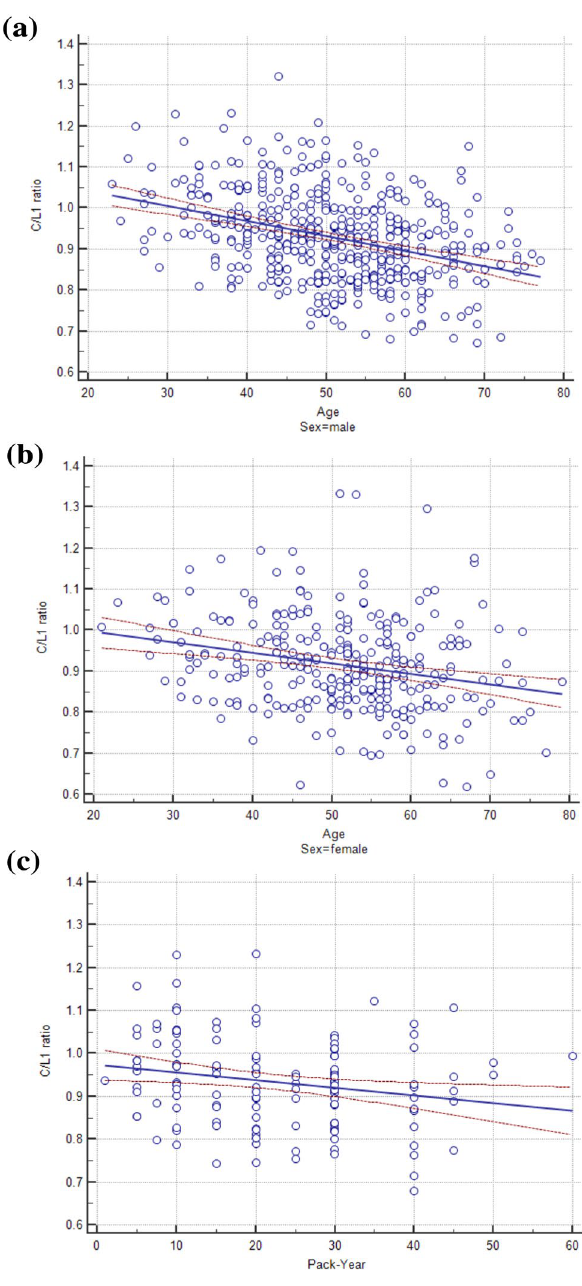
Figure 3. The C/L1 ratio (the ratio of chest wall muscle area at carina and skeletal muscle area at 1st lumbar vertebral level) according to age and smoking status: ( a , b ) The C/L1 ratio decreased with age ( P < 0.001) in general population, and ( c ) pack-year ( P = 0.012) in current